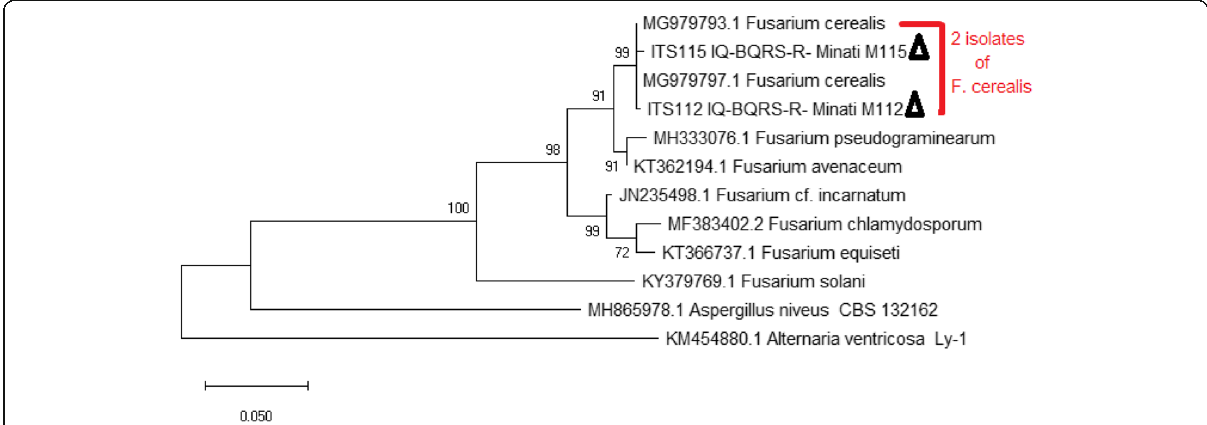
Fig. 11 Phylogenetic tree generated with the ITS-rDNA sequences of the Fusarium cerealis (2), as inferred from the maximum likelihood (ML) analyses (determined by black triangles) and related species retrieved from GenBank. ITS sequences of Aspergillus niveus (MH865978) and Alternaria ventricosa (KM454880) were used as the out-group